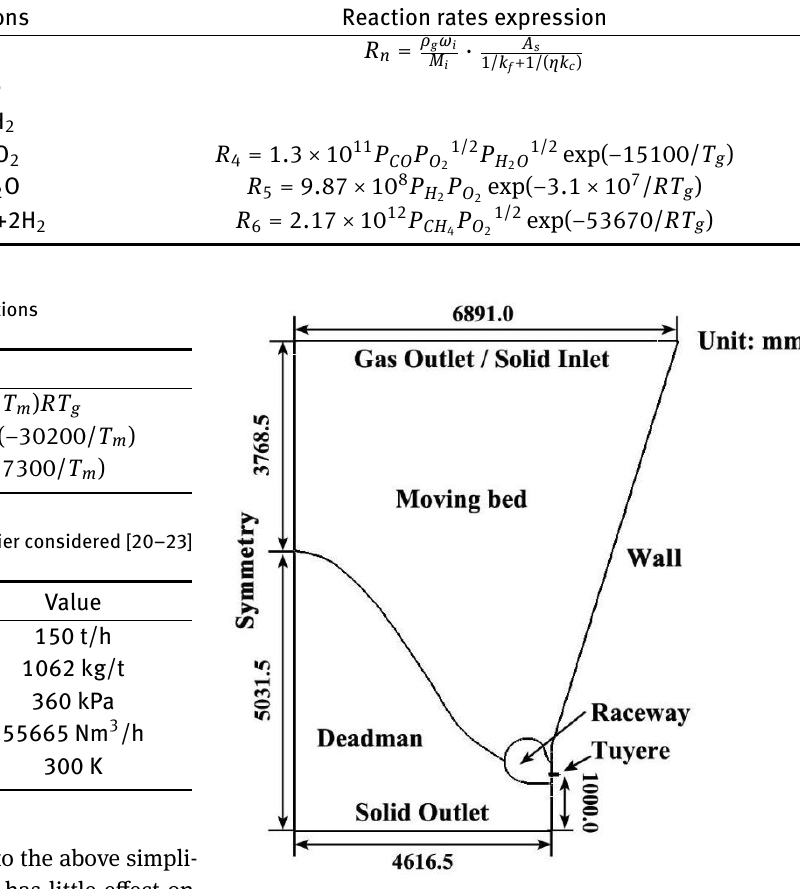
Figure 1: Schematic diagram and boundary conditions of model